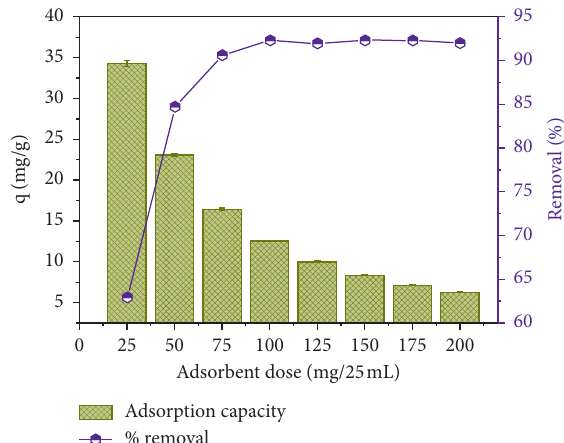
Figure 6: Effect of adsorbent dosage on RhB adsorption by CAC/ CoFe 2 O 4 200 at 50mg/L of initial RhB, 150min of contact time, and initial pH of 4.